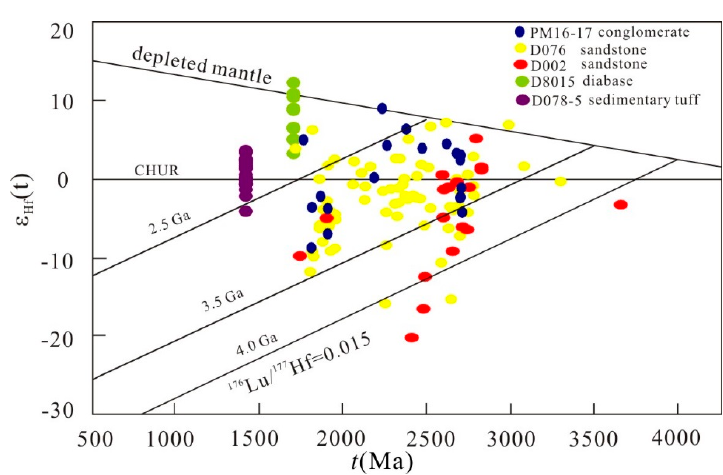
Figure 10. Hf isotope composition of zircons from DCG and a diabase in the western margin of the Yangtze Block.